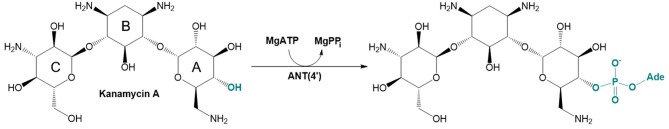
Reaction catalyzed by aminoglycoside O-adenylyltransferase ANT(4′) in MgATP-dependent process of 4′-O-adenylation of kanamycin A.